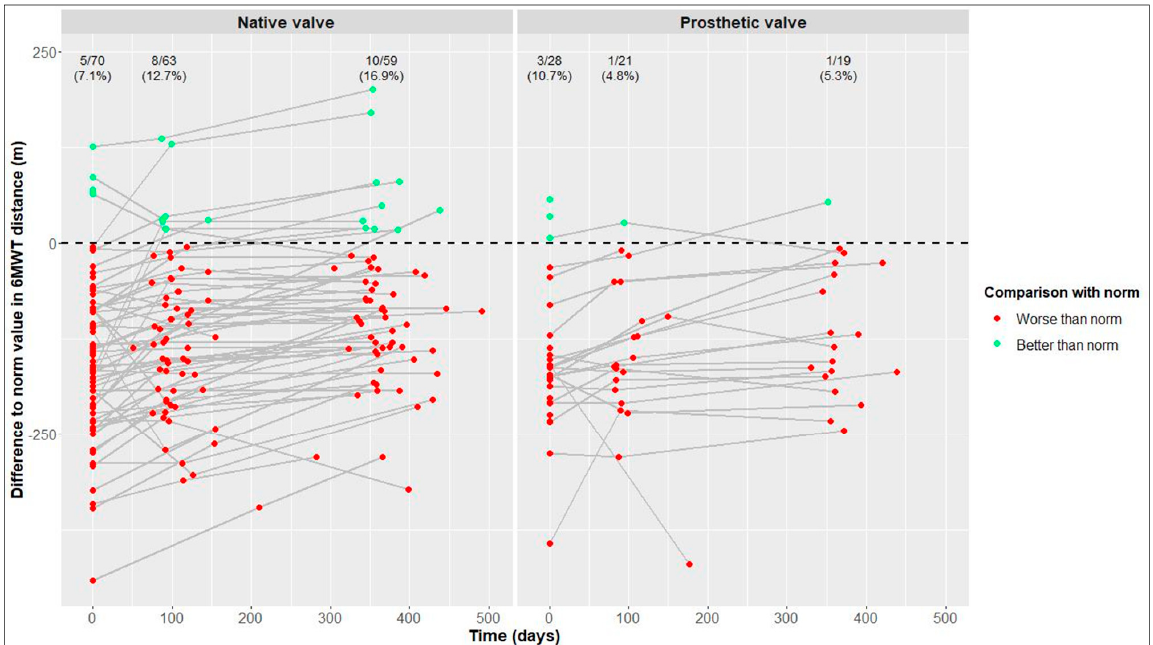
Figure 4. Differences between our values and reference values of six-minute walk test (6MWT) distance [25] in native valve vs. prosthetic valve patients; measurements of individual patients are represented by separate dots and connected to show time trend; absolute and relative frequencies of patients reaching reference values are displayed (raw